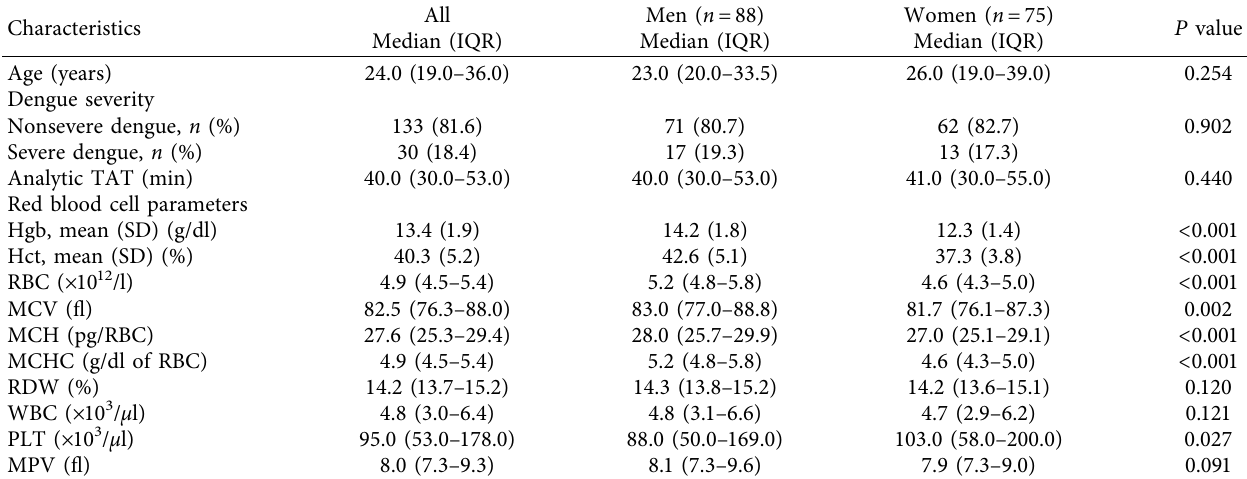
Table 1: Baseline characteristics and red blood cell parameters among 163 patients with confirmed viral dengue infection. Characteristics